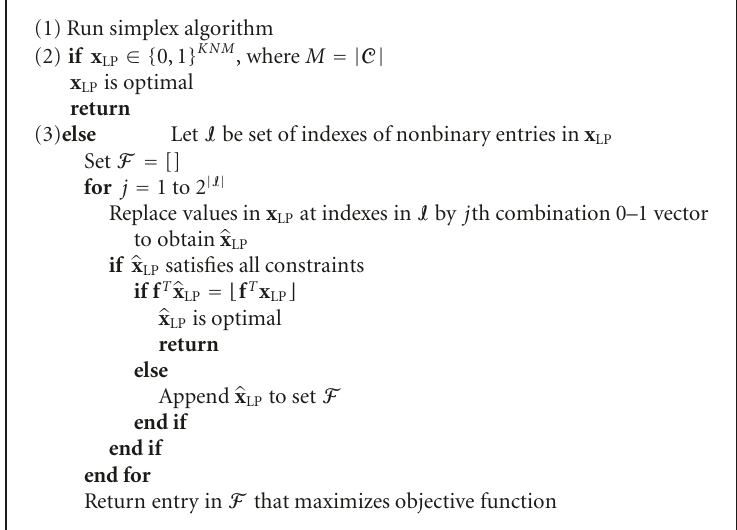
Algorithm 1: Branching operation to obtain binary feasible